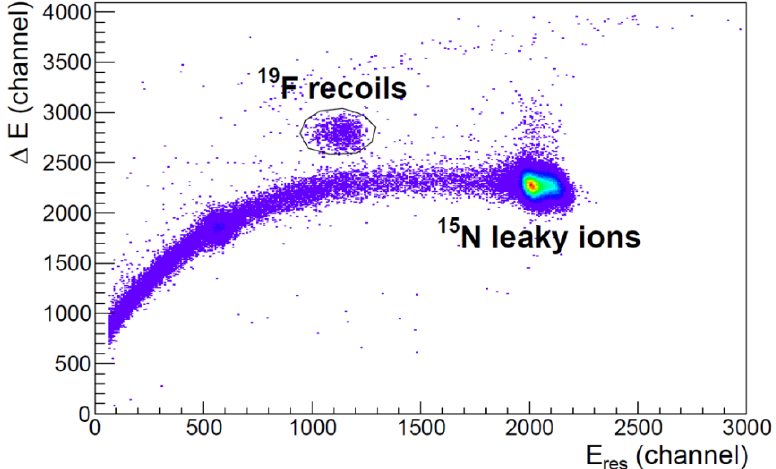
Figure 3. Identification of the fluorine recoils produced in the 15N( α , γ ) 19F reaction with the ICT (ionization chamber telescope).